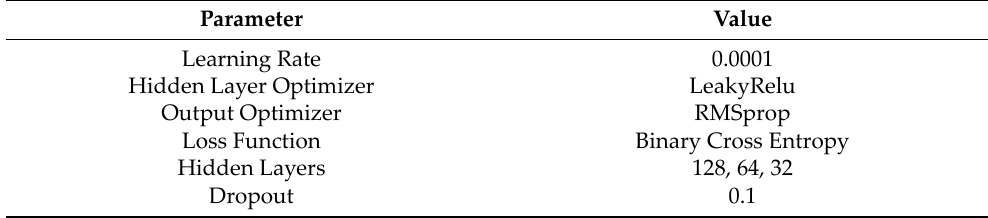
Table 7. GAN Discriminator Neural Network Hyperparameter